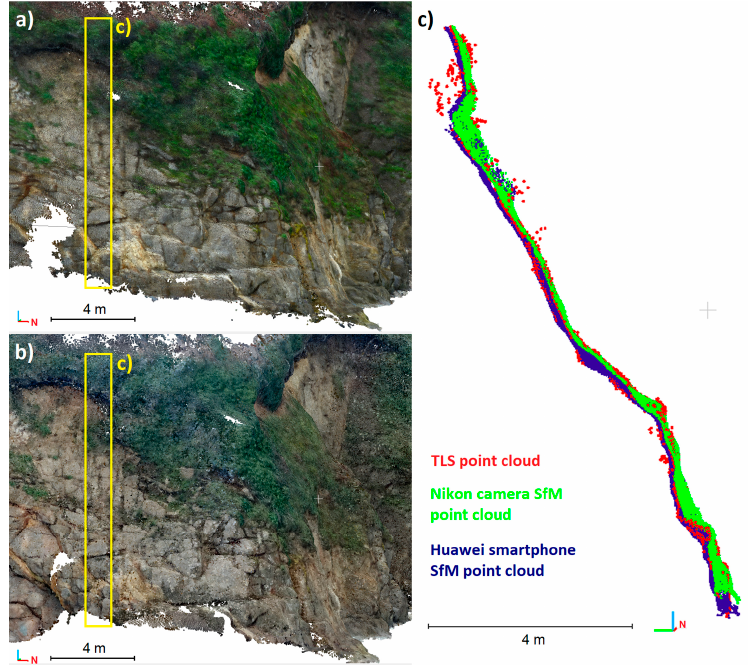
Figure 8. Visual assessment of SfM point cloud quality for the photographs collected using the Nikon D800 Reflex camera ( a ) and the Huawei Y5 Smartphone camera ( b ). ( c ) Vertical topographic profile of the TLS point cloud and SfM point clouds.